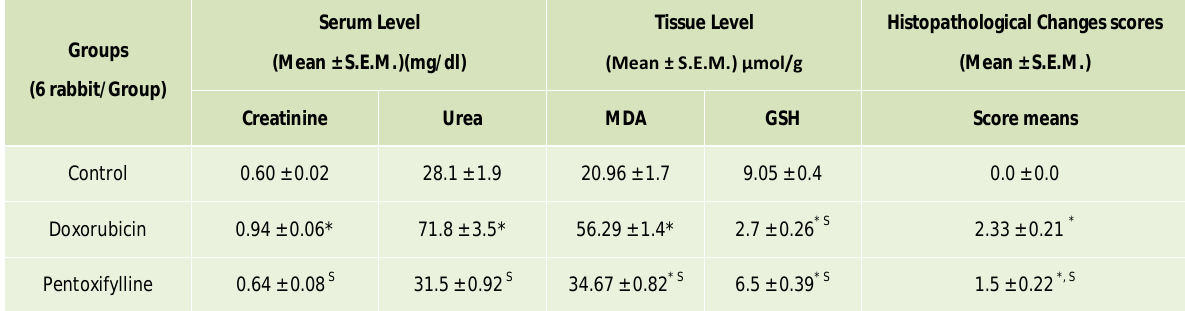
Histopathological Changes scores